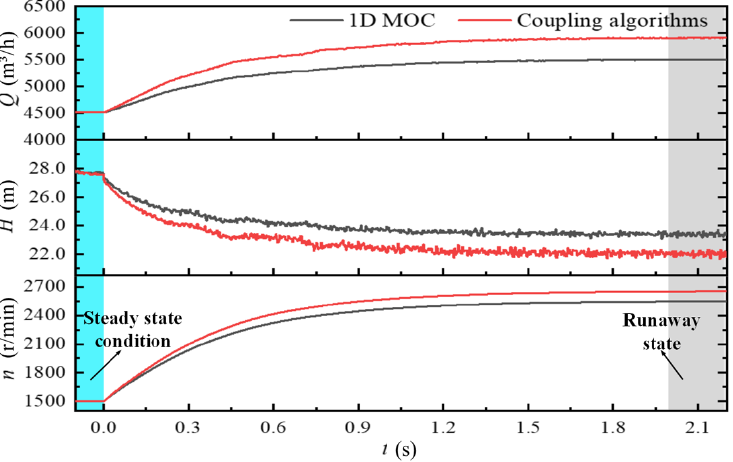
Figure 9. Comparison of the 1D MOC and coupled algorithm results.